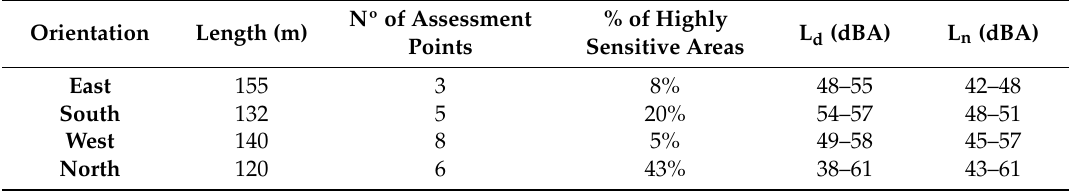
Table 5. Sound levels obtained at facades and percentages of areas highly sensitive to